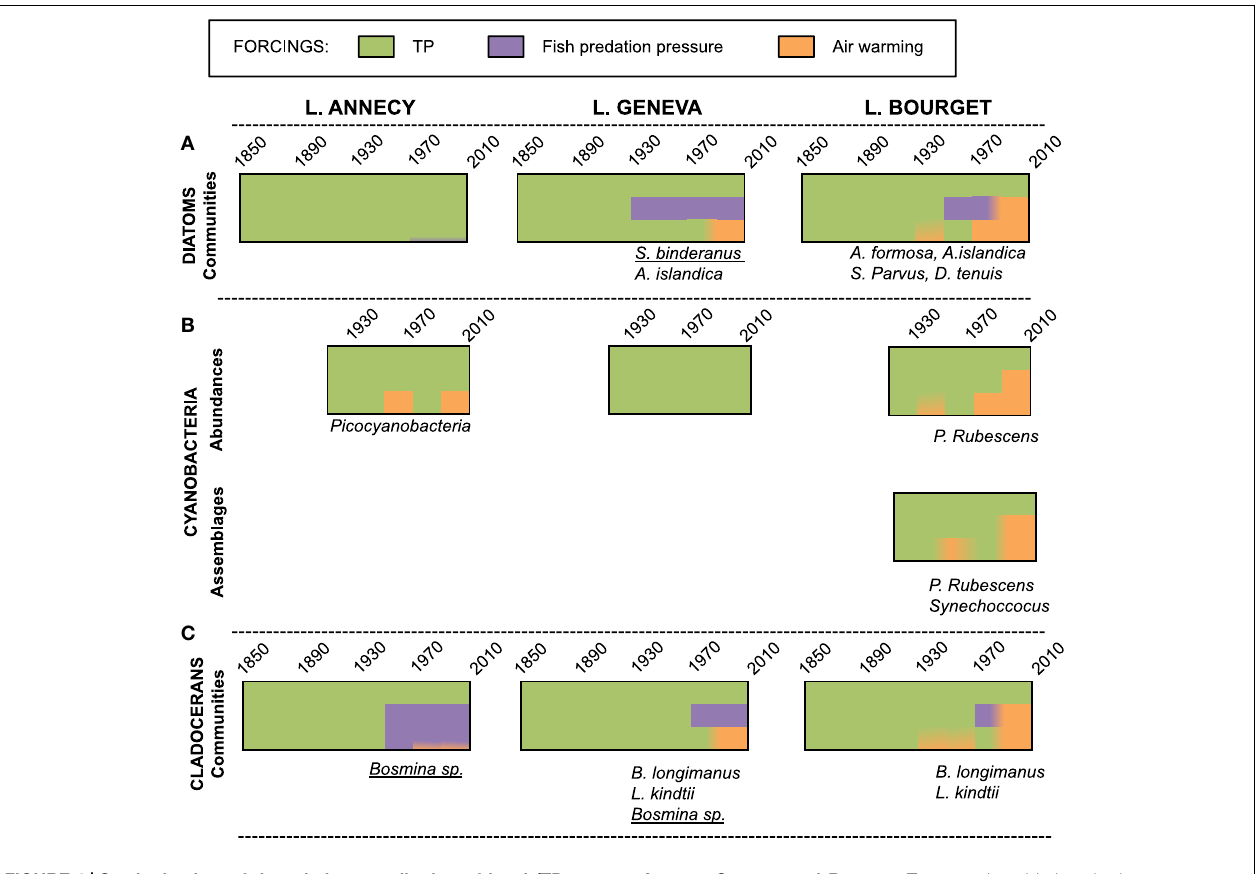
Annecy, Geneva, and Bourget. Taxa mentioned below the bars are those that are favored by the recent air warming in each lake, either by direct effects, or through a fish-predation mediated effect (when